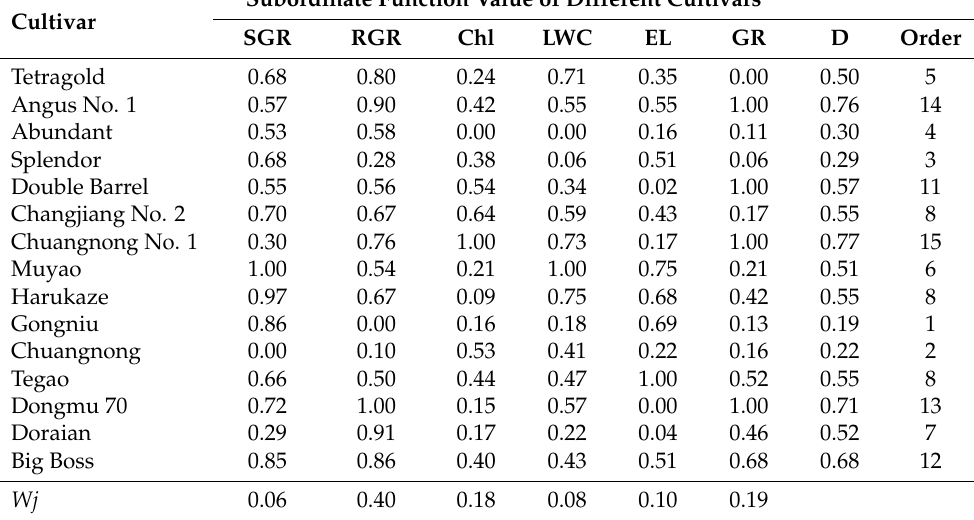
Table 2. The values of the subordinate function, integrated value (D), and order of each cultivar under salt stress. SGR means shoot growth rate, RGR means root growth rate, Chl means chlorophyll content, LWC means leaf relative water content, EL means electrical conductivity, GR means germination rate (on the 12th day) and Wj is the weighted